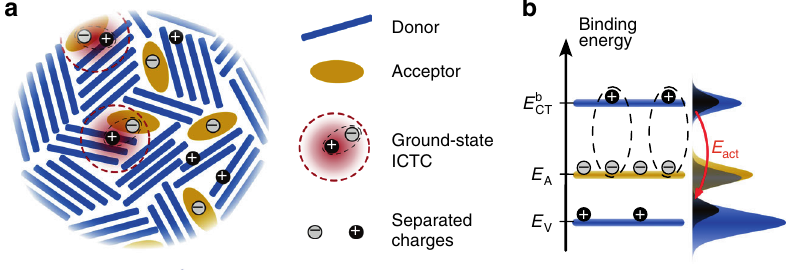
Fig. 1 Sketch of the two-step process of molecular doping. a Illustration of charged species in a p-doped organic semiconductor fi lm: integer-charge transfer from donor to acceptor molecules, DA → [D + A − ], yields ground-state integer-charge transfer complexes (ICTCs), which are thermally dissociated into separated charges. b Sketch of a statistical two- or complete three-level model for p-doping. Black and gray distributions indicate the occupations of Gaussian broadened levels E V or E CT b (each blue) with holes and acceptor states E A (yellow) with electrons, respectively. The energy required for ICTC dissociation is reduced from E CT b — E V to E act due to energetic disorder, i.e., from several 100 mV to effectively only a few tens of meV. ICT itself is temperature-independent. Incomplete ICT occurs if IE (D) > EA (A), which is expressed by E A describing the degree of acceptor ionization in